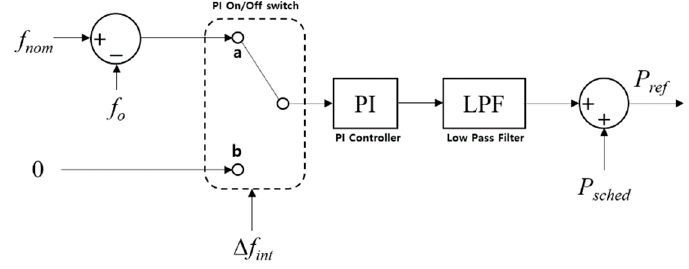
Figure 2. Proposed active power reference controller for grid-feeding distributed generation (DG).